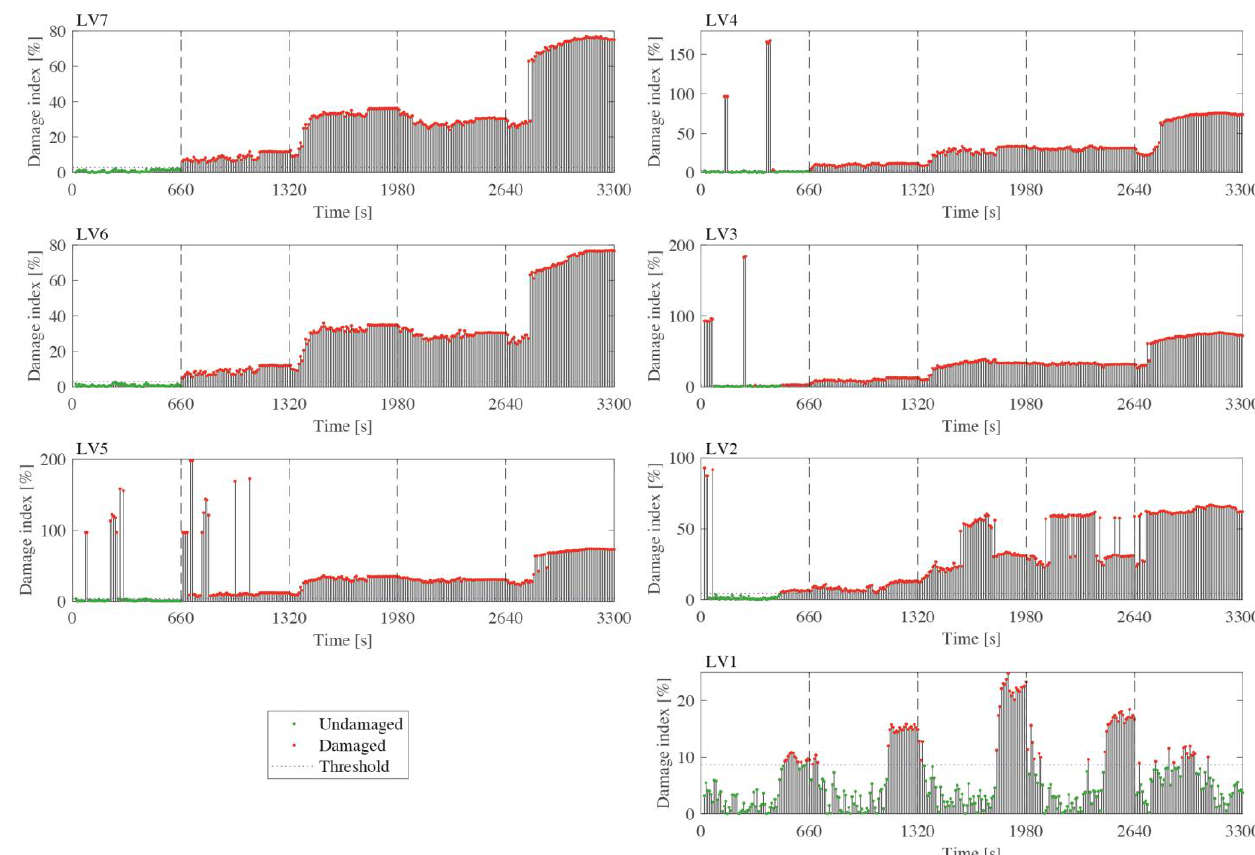
Figure 6. Parameters identified from model fitting.